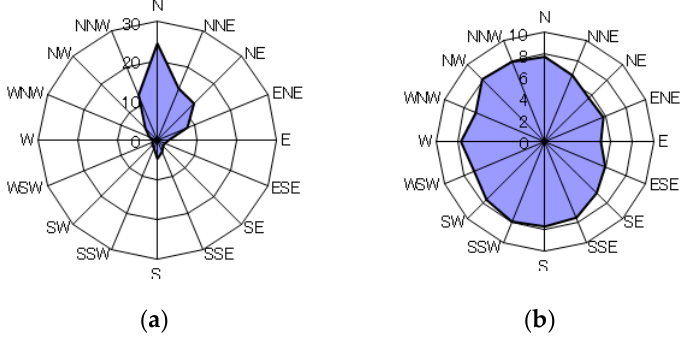
Figure 5. Characteristics of wind at Noma Wind Park, WT #4, for the month of February 2003. ( a ) Occurrence frequency (%); ( b ) monthly average wind speed (m/s).